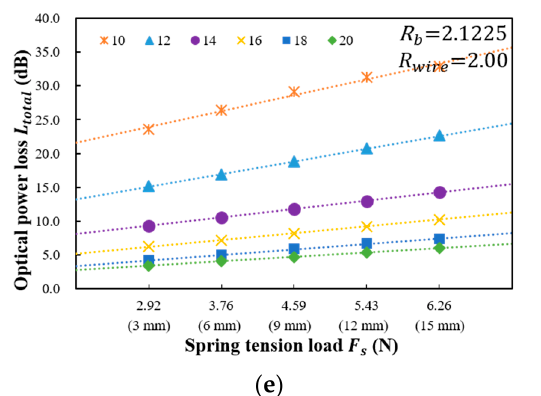
Figure 4. Measured optical power loss (dB) versus spring tension load 𝐹 (cid:3046) (N) and spring deflection length 𝑧 (mm) for various distances between the steel wires. The bending radii 𝑅 (cid:3029) are ( a ) 0.6225 mm; ( b ) 0.8725 mm; ( c ) 1.1225 mm; ( d ) 1.6225 mm; ( e ) 2.1225 mm.